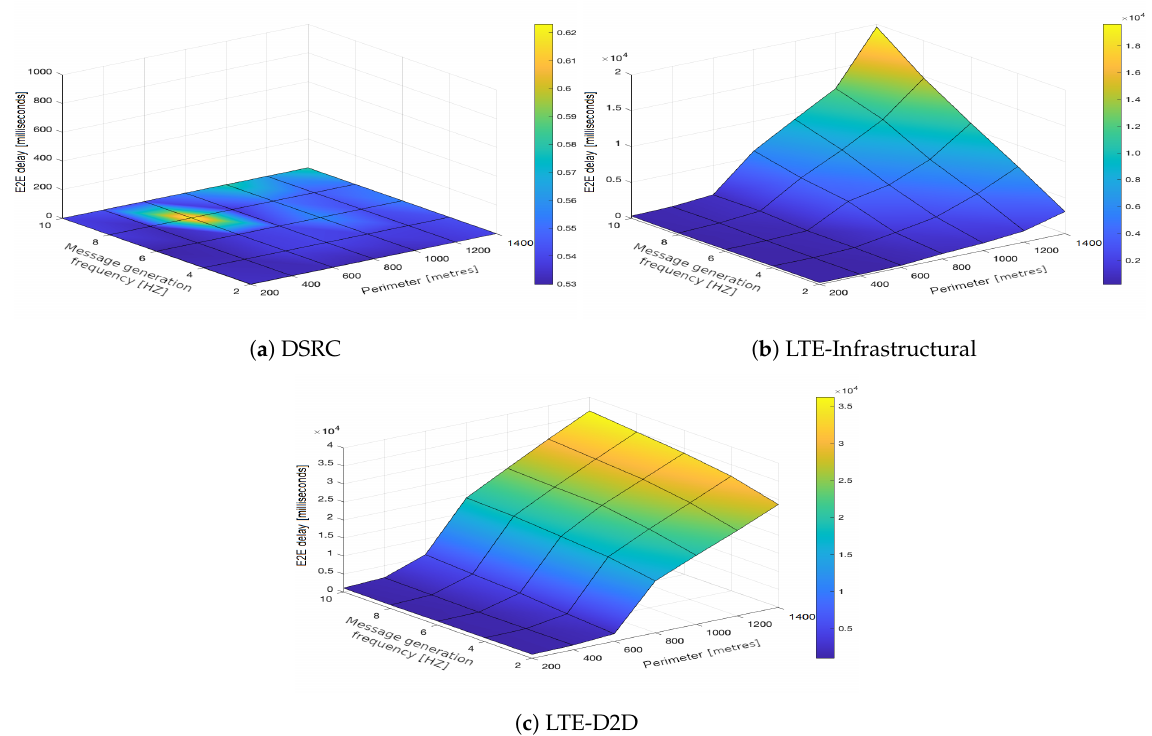
Figure 8. End-to-end delay obtained for the traffic intensity of 250 vehicles per